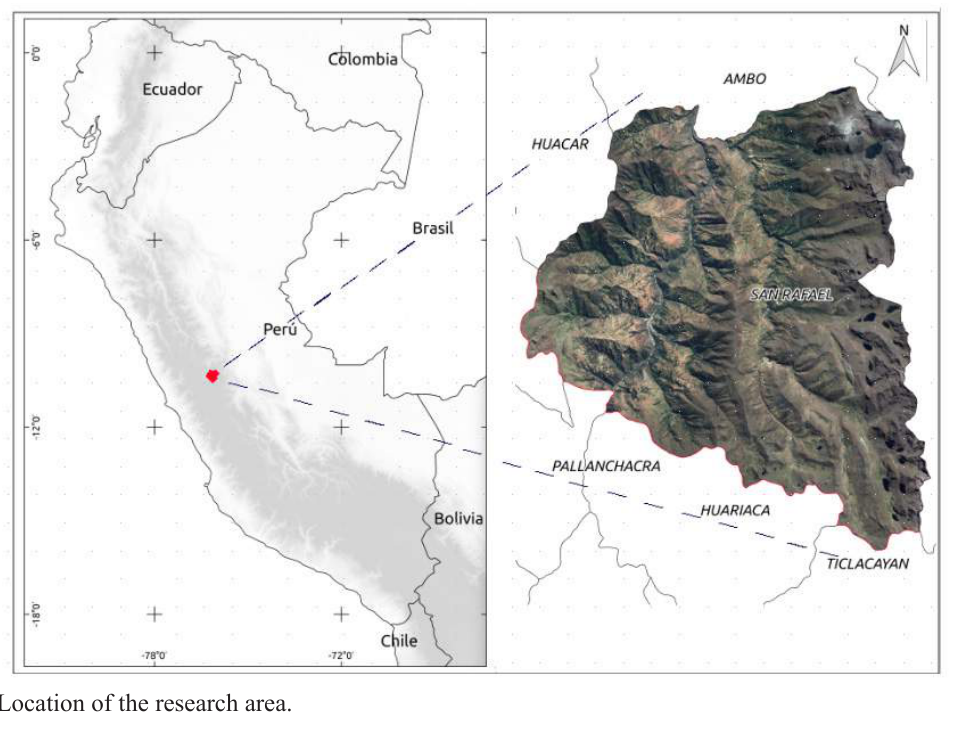
Figure 1: Location of the research area.